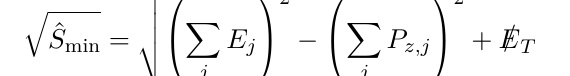
Figure 9. Left panel: normalized distribution of the BDT response for both signal (blue, BP3) and background (red) classes (both training and testing samples of both classes). Right panel: signal (blue) and background (red) efficiencies and the statistical significance of the signal (green) as a function of cut applied on BDT